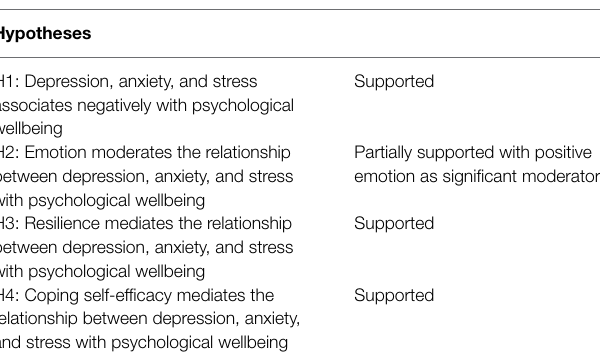
TABLE 9 | Summary of hypotheses.